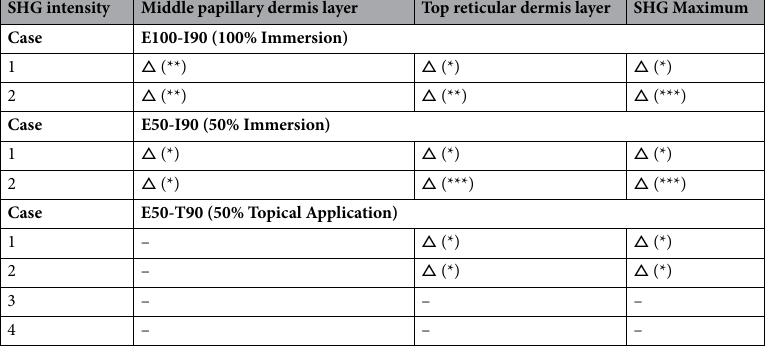
Table 3. Statistical analysis result on the SHG intensity variation after the glycerol application. −: no significant difference, △ : Increased significantly, ▽ : Decreased significantly, * P < 0.05, ** P < 0.01, *** P <